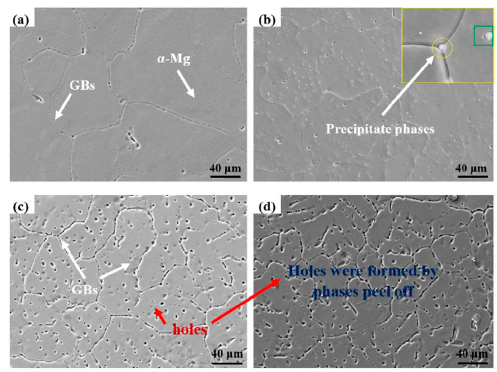
Figure 1. SEM morphologies of as-receive MZM-xCa alloys with homogenization treatment: ( a ) 0%; ( b ) 0.38%; ( c ) 0.76%; and ( d ) 1.10%.